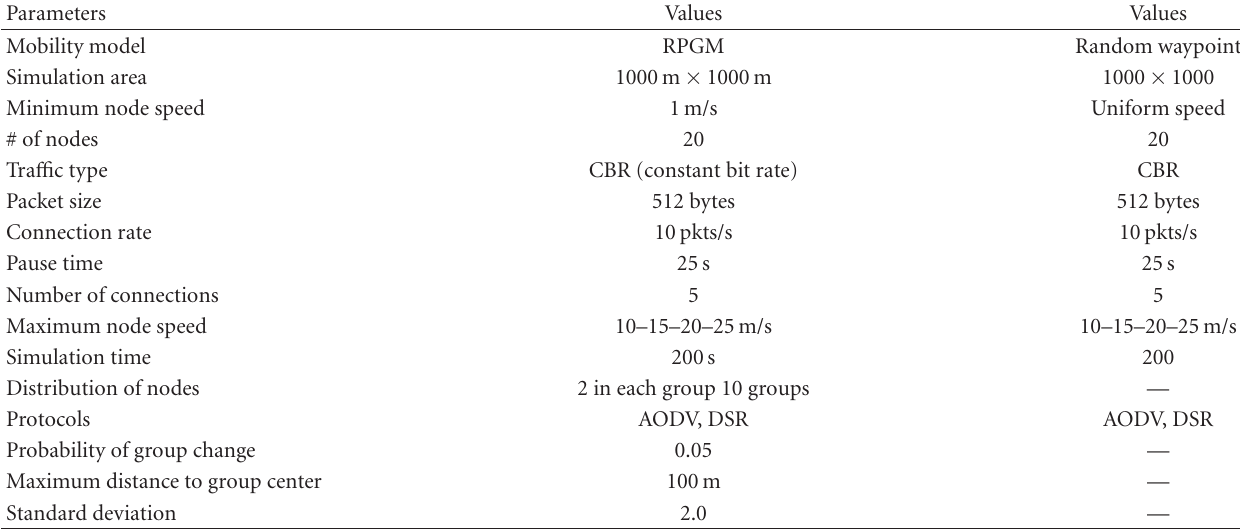
Table 1: Parameters for RPGM and random waypoint model-mobility variations.